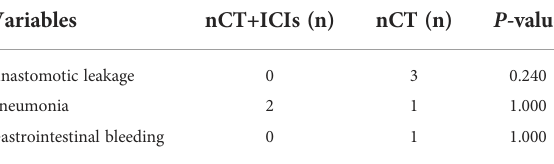
TABLE 5 Complications after